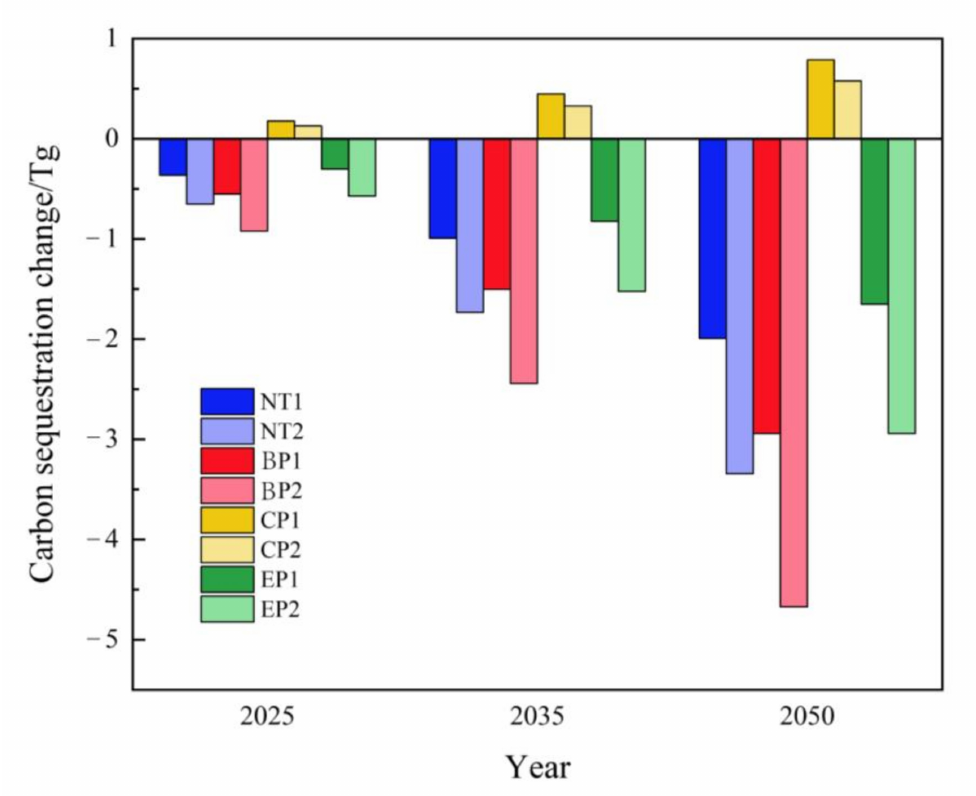
Figure 12. Changes in carbon storage relative to 2019 under different future development scenarios. 1 denotes Pattern 1 and 2 denotes Pattern